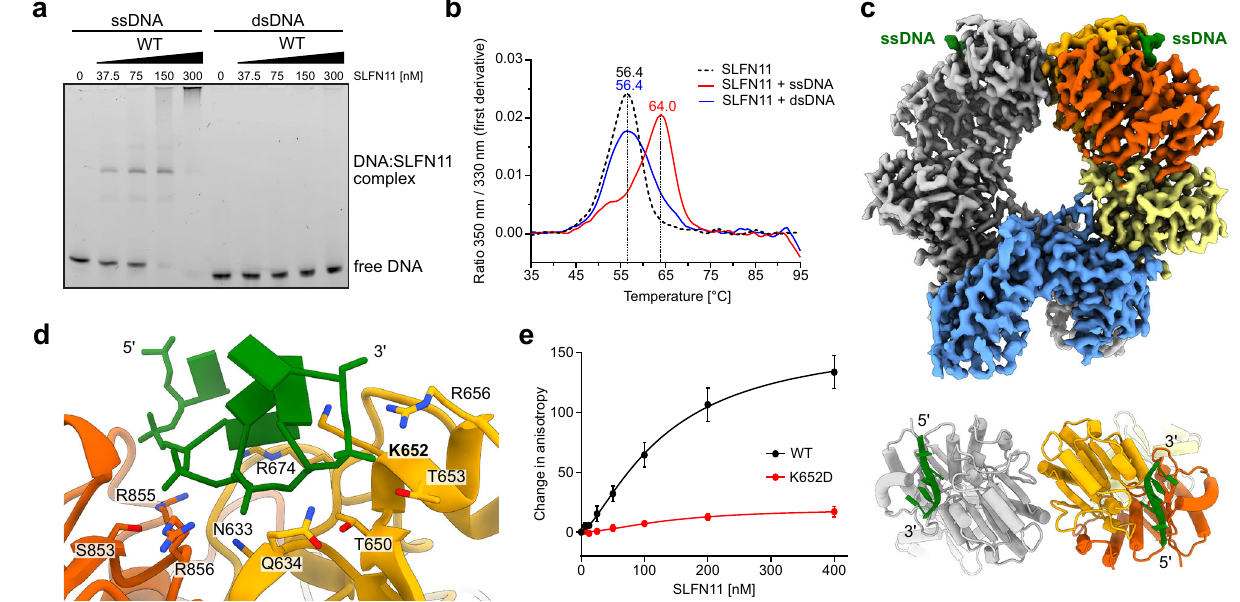
Fig. 3 | SLFN11 binding to DNA. a ssDNA and dsDNA binding ability of SLFN11 monitored by electrophoretic mobility shiftassay. The experiment wasperformed in duplicates. One representative replicate is shown. b NanoDSF measurements of SLFN11 in the presence of ssDNA and dsDNA. c Cryo-EM reconstruction of the SLFN11 wt dimerboundtossDNA.TopviewofssDNAboundbetweenthehelicaseN- and C-lobesof SLFN11with indicated5´to 3´ direction. d Detailed viewoftheDNA